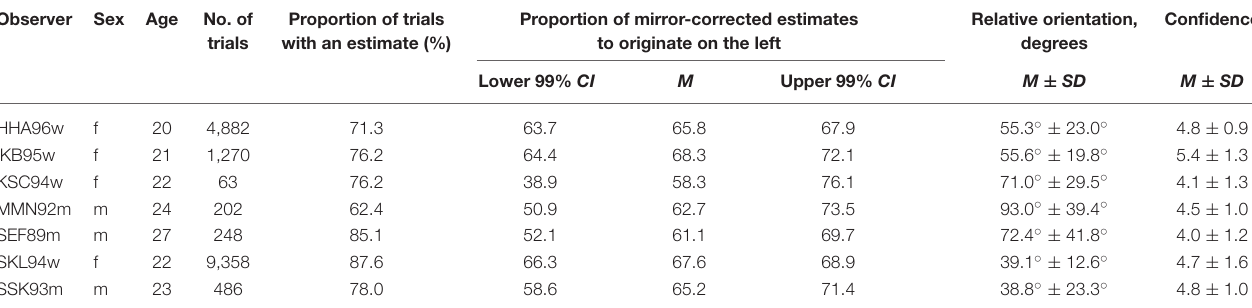
Proportion of trials trials with an estimate